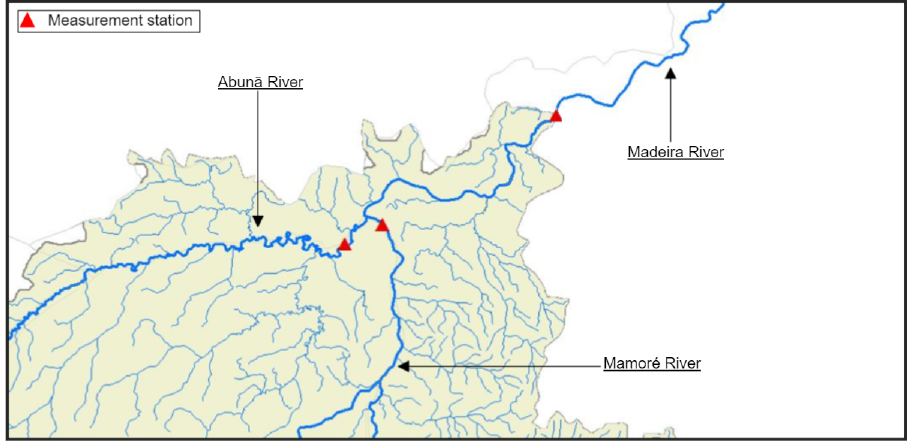
Figure 2. Madeira river